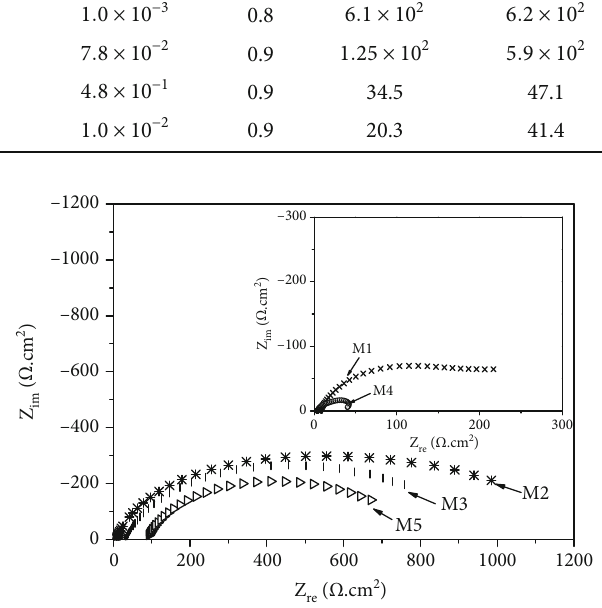
Figure 6: Nyquist plots for aluminum-based alloy doped with Mn and Co after heat treatment at 1100 ° C immersed in 3M KOH.